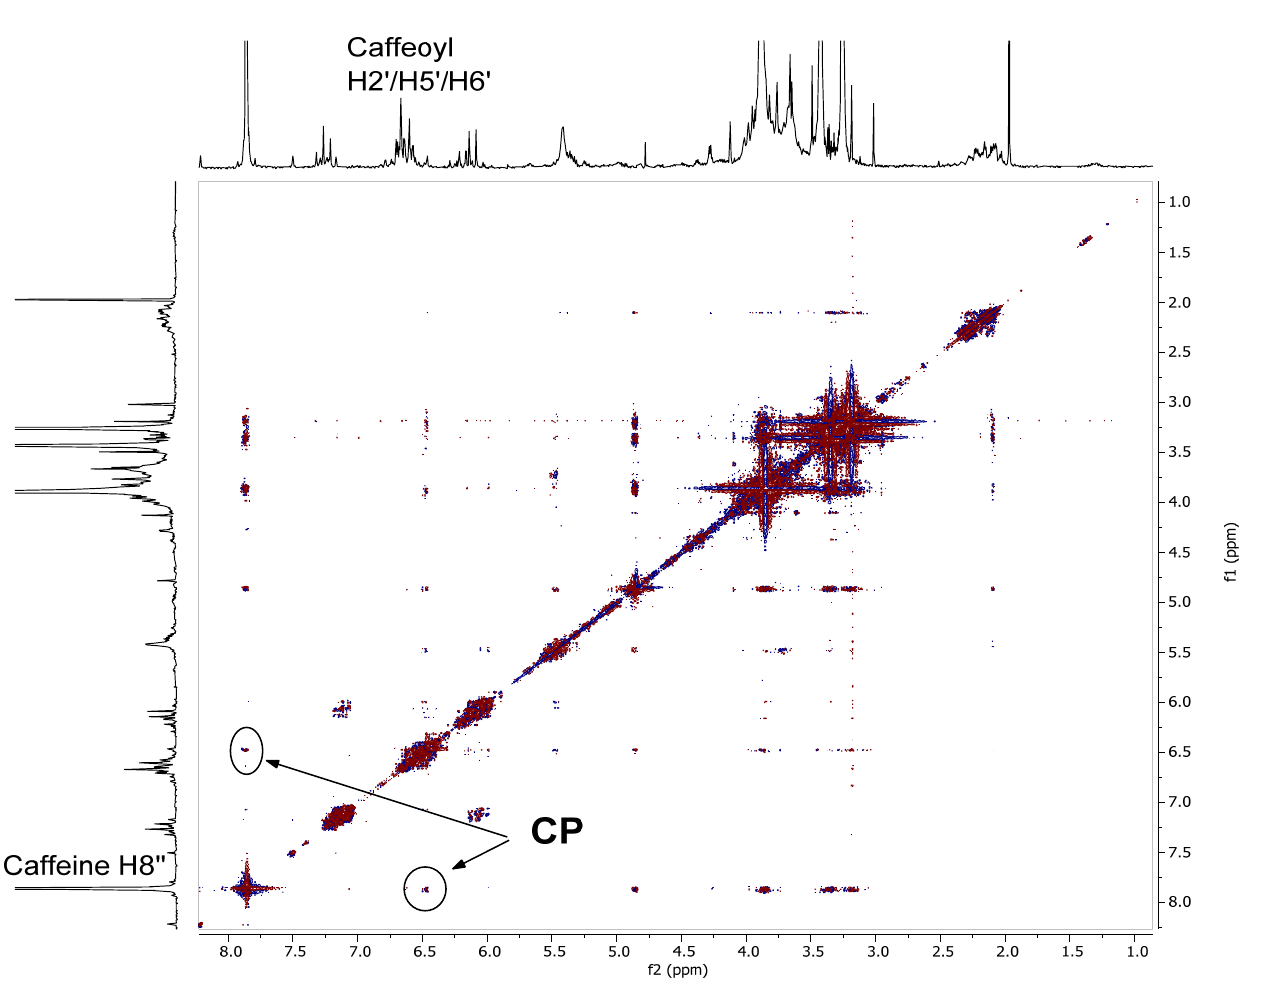
Figure 12. 1 H- 1 H 2D-NOESY NMR experiment with a mixing time of 150 ms performed on CEW-CCE. Cross peaks indicated with “CP” demonstrate through-space close proximity of caffeine H8” to the caffeoyl H2 (cid:48) /H5 (cid:48) /H6 (cid:48) aromatic protons. Shows aromatic stacking in complex